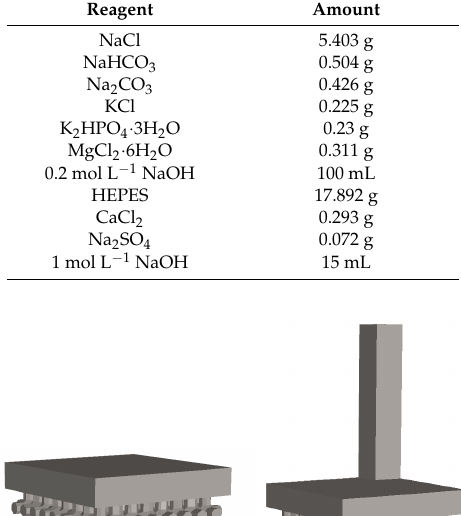
Table 2. Composition of 1000 mL solution of a modified SBF [33].